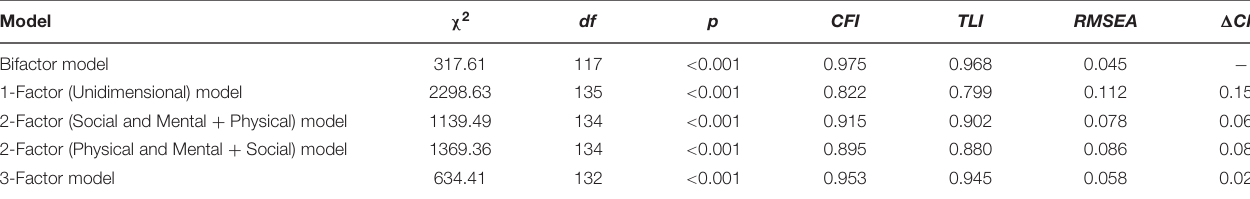
TABLE 2 | Fit statistics for the confirmatory factor analysis models ( N = 1507).